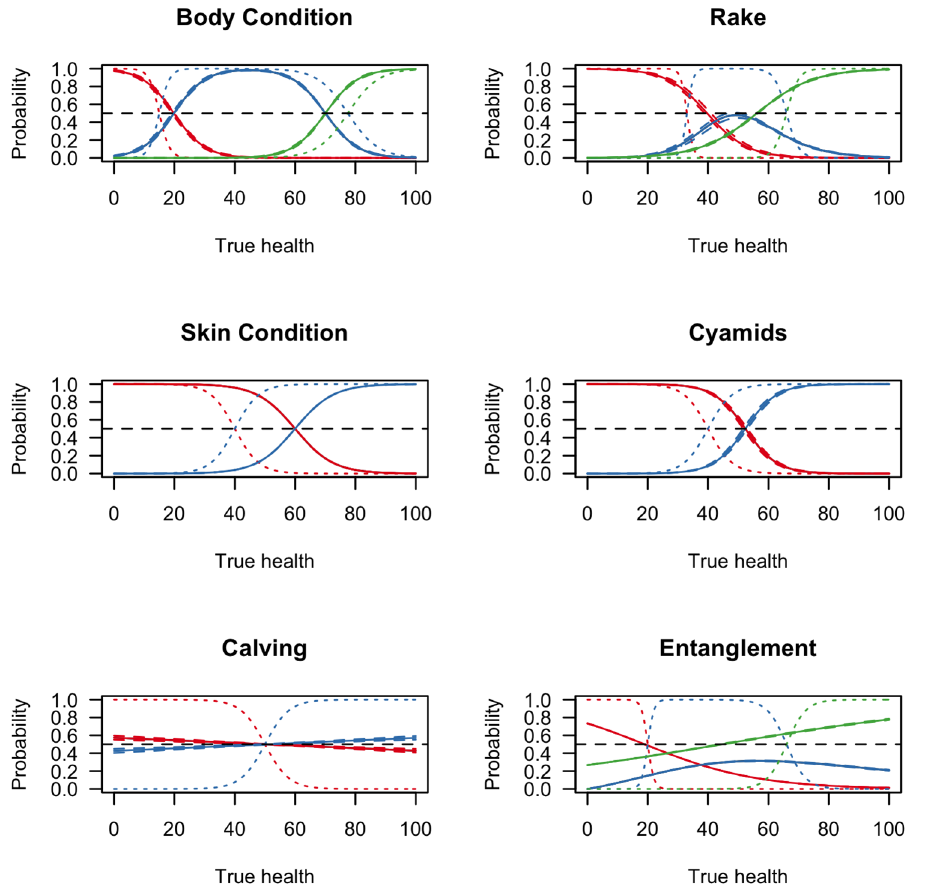
Figure 12. Relationship between h and H . Graphical representation of the parameters in matrix c, which relate observed health H to true health h . The solid curves represent the estimated probability with uncertainty (dashed lines) that given an estimate of true health h , the animal would be seen in a given health class for each of the 6 health parameters. Priors are depicted with dotted lines. Estimates for the parameters governing body condition, rake marks, skin condition, and cyamids show a clear relationship between true health status and observed health. In contrast, the relationship between calving and entanglement and true health is not clear.